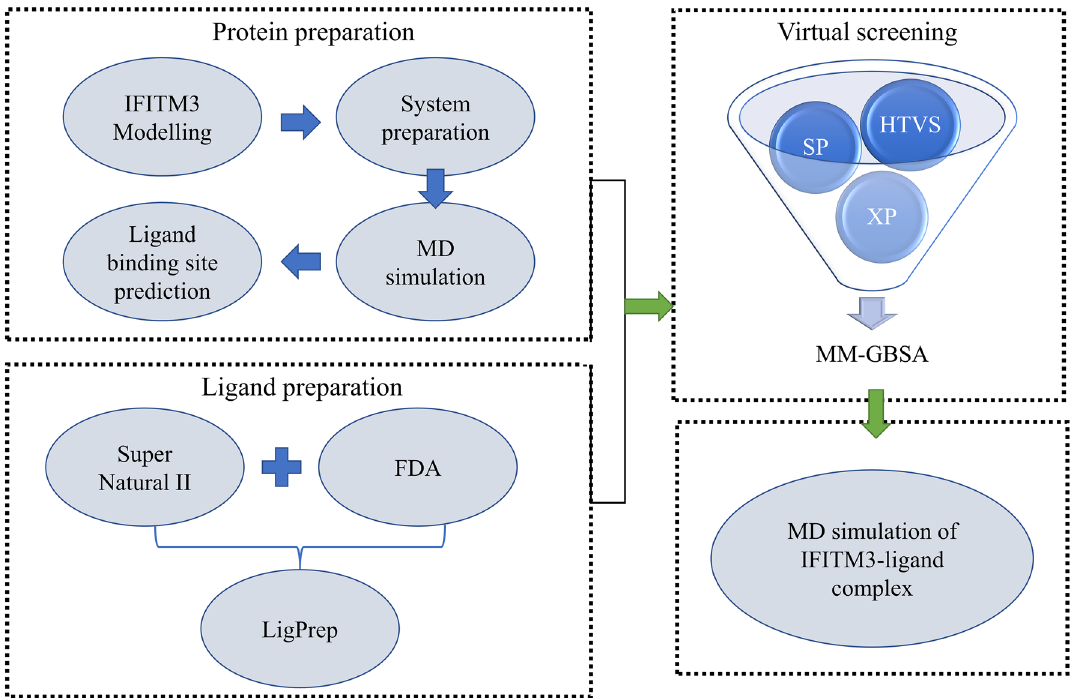
Figure 1. Workflow of IFITM3 modelling and virtual screening. Structure of IFITM3 was modelled followed by simulation and binding site prediction. Ligands were prepared using LigPrep module of Schrodinger. The virtual screening involved HTVS, SP and XP docking protocol. The docked complexes were subjected to MD simulation. HTVS high-throughput virtual screening, SP standard precision, XP extra